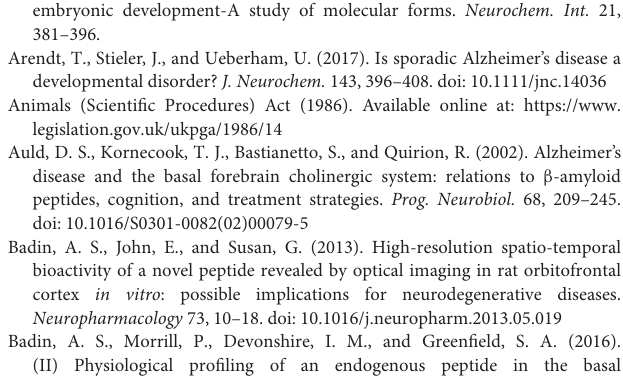
Supplementary Figure 1 | Uncropped original blots showing T14 and α 7-nAChR expression and interaction after co-immunoprecipitation in Figure 2 . (A) Co-IP on ex-vivo brain slices and (B) whole brain lysate. Supplementary Figure 2 | Uncropped original blots showing T14 expression in Figure 3 . (A) Ctrl vs. T30, (B) Ctrl vs. NBP14, (C) T30 vs. NBP14 + T30, (D) Ctrl vs. T15. Supplementary Figure 3 | Uncropped original blots showing α 7-nAChR expression in Figure 4 . (A) Ctrl vs. NBP14, (B) T30 vs. NBP14 + T30, (C) Ctrl vs. T15. Supplementary Figure 4 | Uncropped original blots showing A β expression in Figure 5 . (A) Ctrl vs. NBP14, (B) T30 vs. NBP14 + T30, (C) Ctrl vs. T15. Supplementary Figure 5 | Uncropped original blots showing p-Tau expression in Figure 6 . (A) Ctrl vs. NBP14, (B) T30 vs. NBP14 + T30, (C) Ctrl vs.